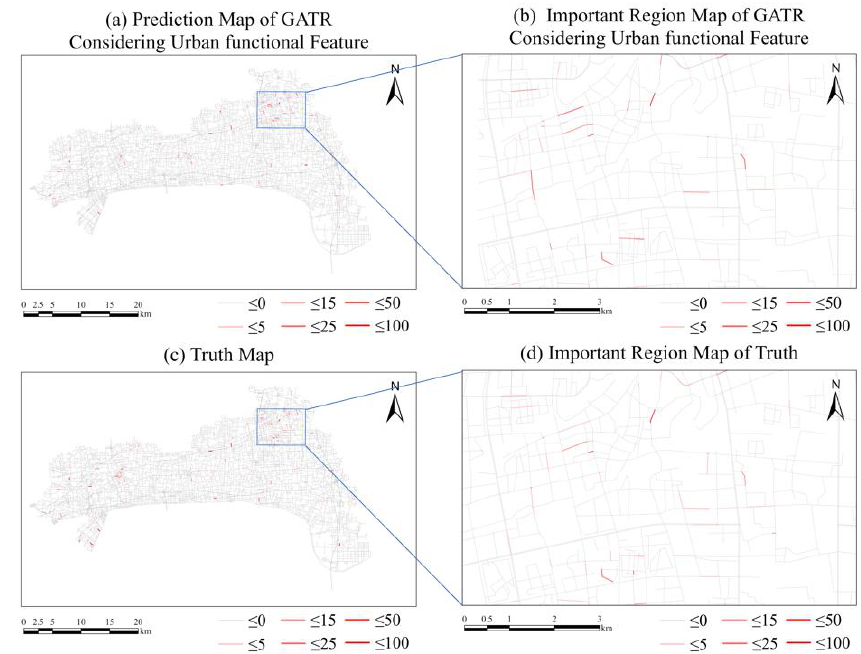
Figure 12. Comparison between the predicted result using GATR improved by urban functional feature and the truth. ( a ) Predicted result of traffic violations using GATR considering urban functional features. ( b ) Important region map of GATR. ( c ) Truth values of traffic violations. ( d ) Important region truth values of traffic